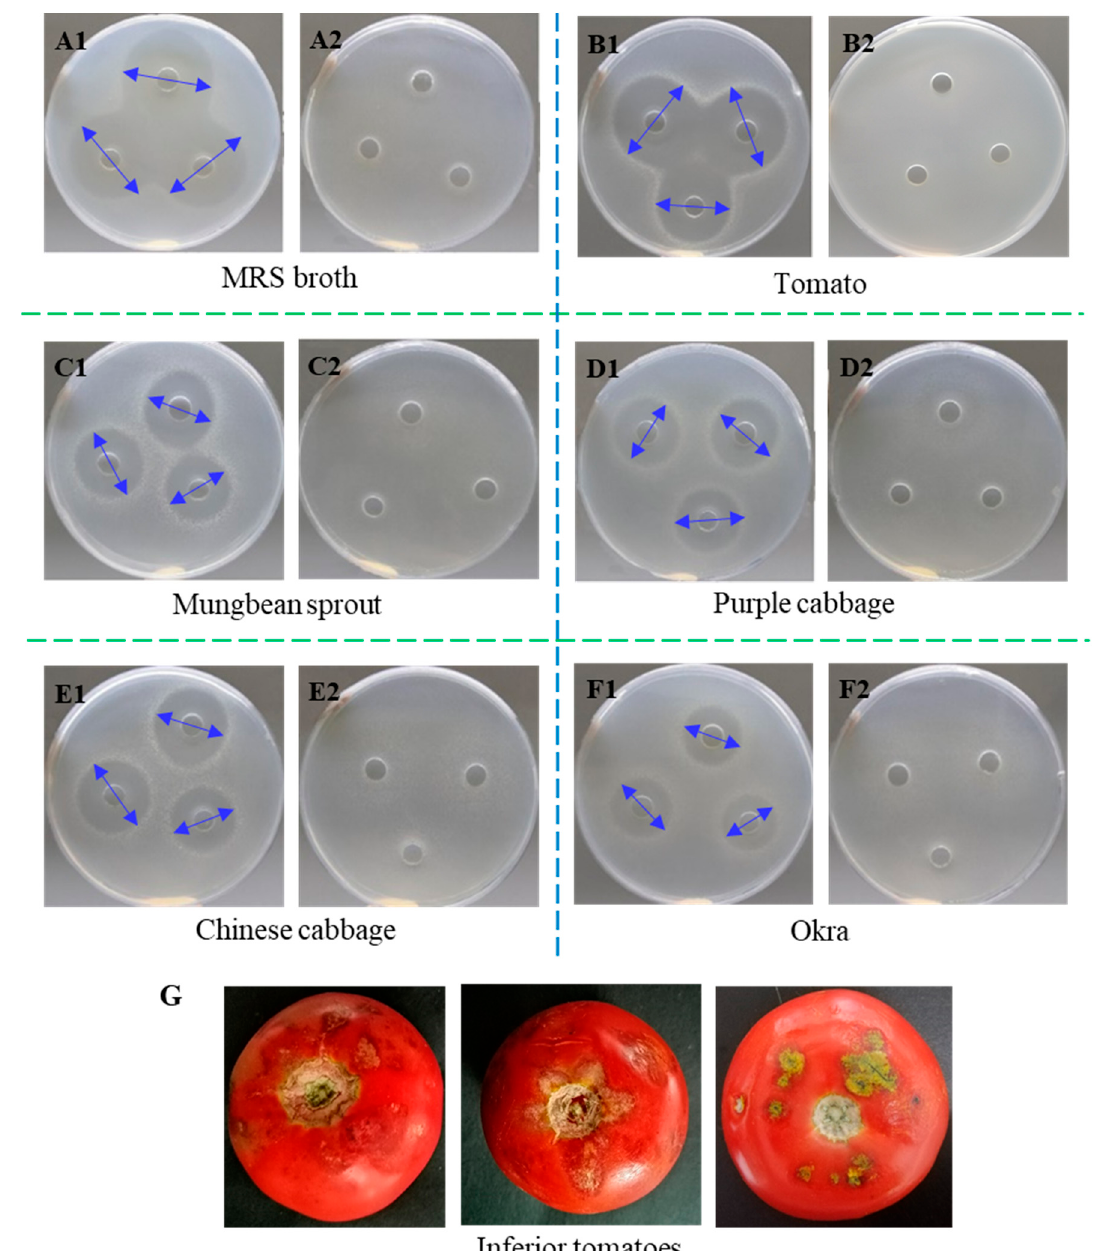
Figure 1. Antibacterial activity of fermentation supernatant. ( A1 ), Man-Rogosa-Sharpe broth with L. paracasei WX322 as a reference; ( A2 ), Man-Rogosa-Sharpe broth without L. paracasei WX322 as a reference. ( B1 ), Tomato with L. paracasei WX322; ( B2 ), tomato without L. paracasei WX322. ( C1 ), Mungbean sprout with L. paracasei WX322; ( C2 ), mungbean sprout without L. paracasei WX322. ( D1 ), Purple cabbage with L. paracasei WX322; ( D2 ), purple cabbage without L. paracasei WX322. ( E1 ), Chinese cabbage with L. paracasei WX322; ( E2 ), Chinese cabbage without L. paracasei WX322. ( F1 ), Okra with L. paracasei WX322; ( F2 ), okra without L. paracasei WX322. ( G ), Inferior products of tomato as an example. Inhibition zone diameter was marked by blue arrows.